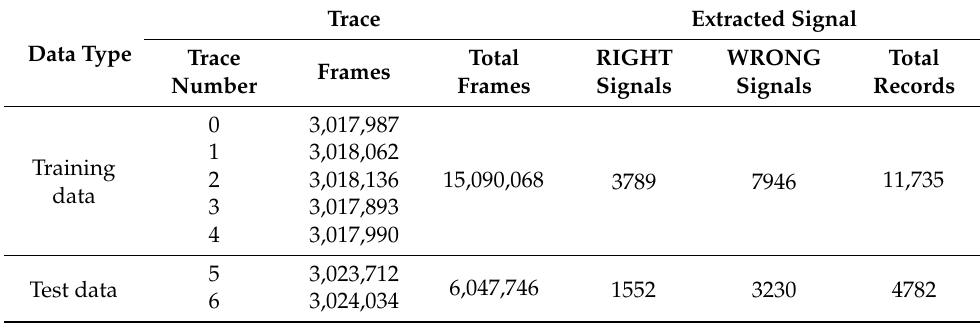
Table 2. Composition of the synthetic CAN dataset.